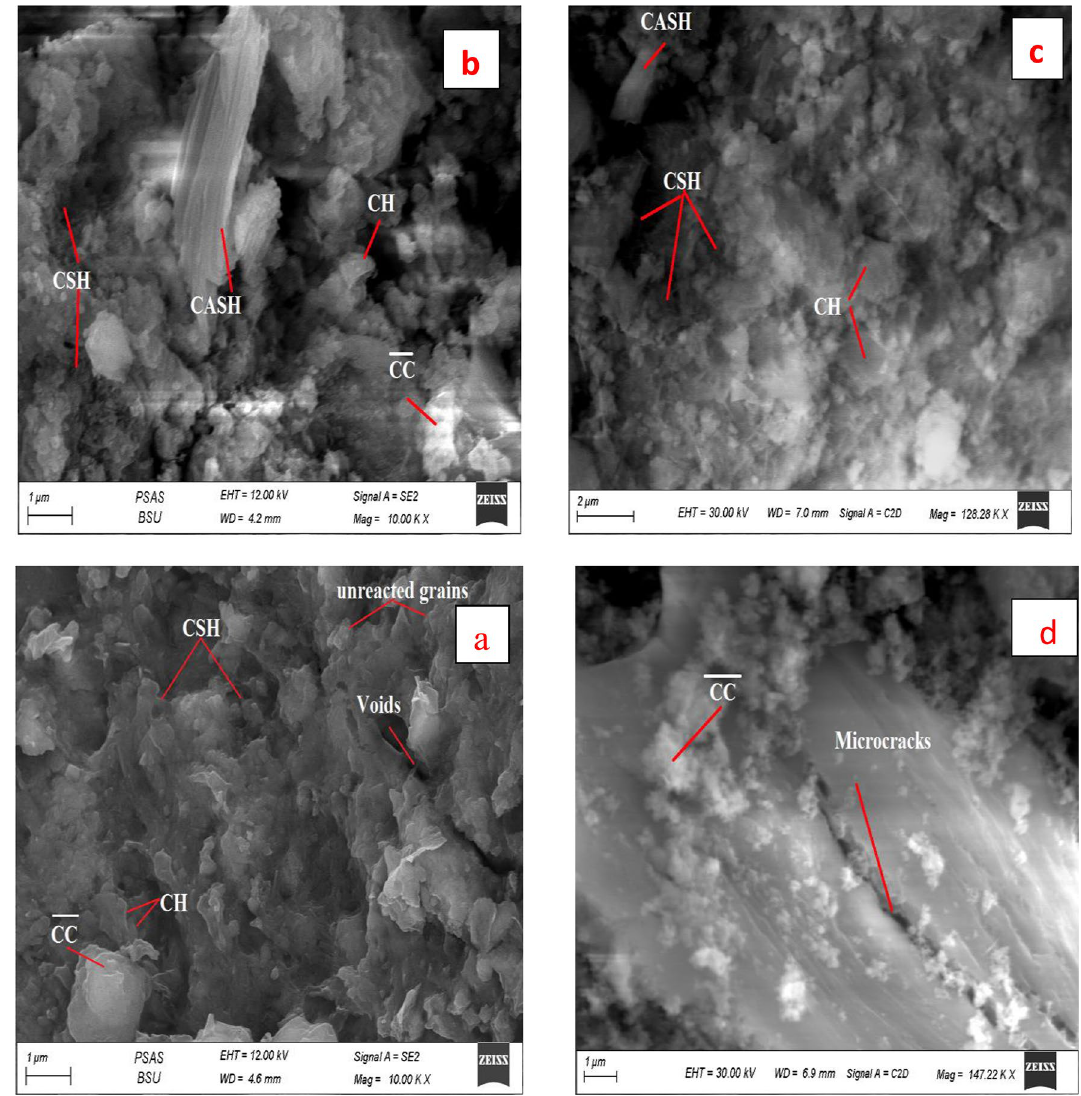
Figure 20. SEM micrographs hardened nanocomposite made from mix CNMFs0.5: ( a ) after 7 days, ( b ) after 28 days, ( c ) after firing at 300 °C and ( d ) after firing at 800